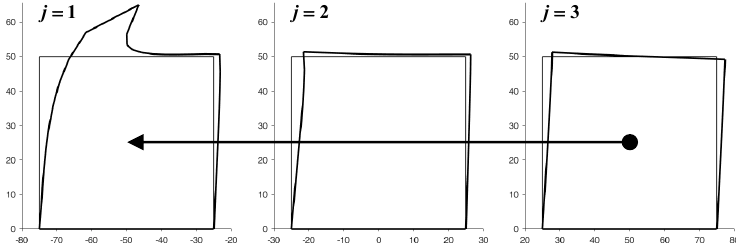
Figure 16. First iteration from right to left: the j -th element generates the displacements on the right side of the ( j − 1 ) -th element, with j = 3,2 (Thin line: undeformed configurations. Thick line: deformed configurations. Amplification factor of the displacements: k = 200 ).